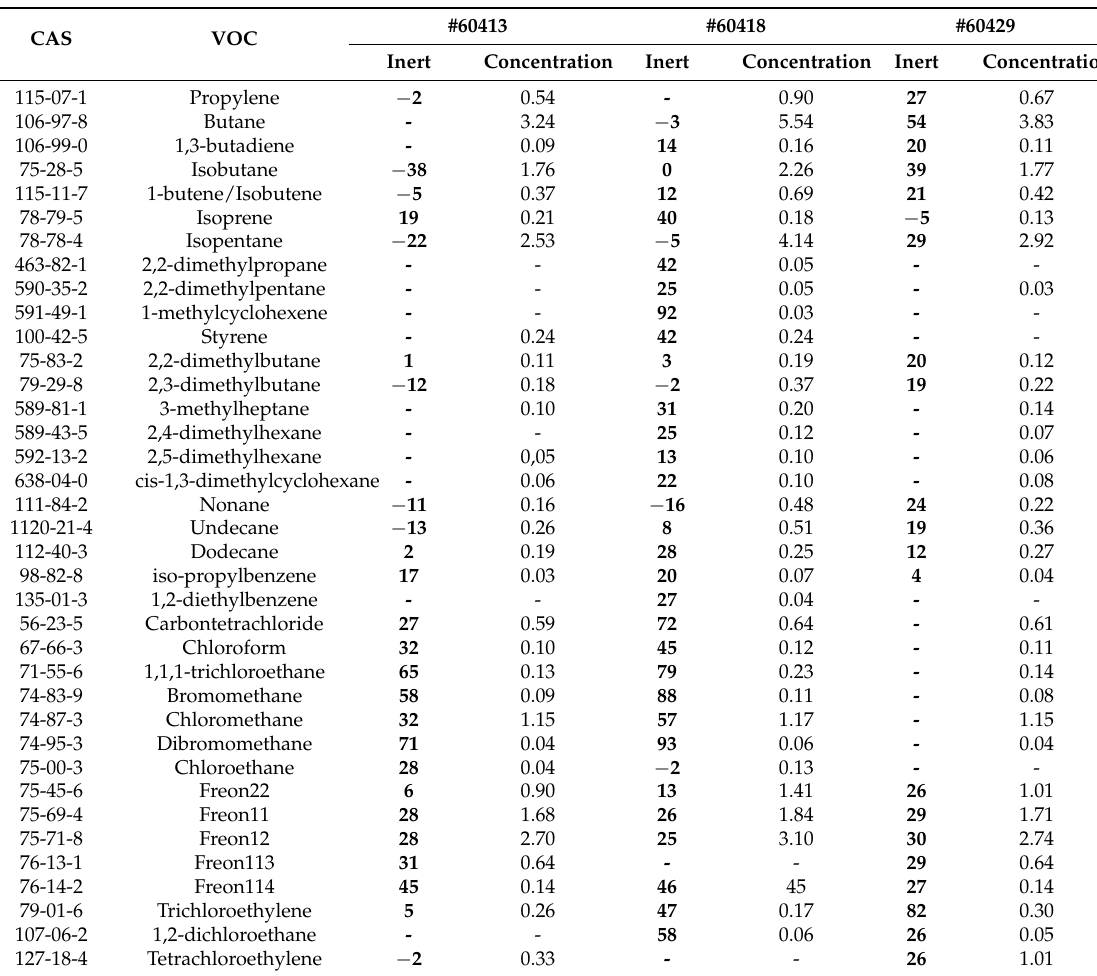
Table 3. Profiles of the “stable” source at three locations: stations #60413, #60418, and